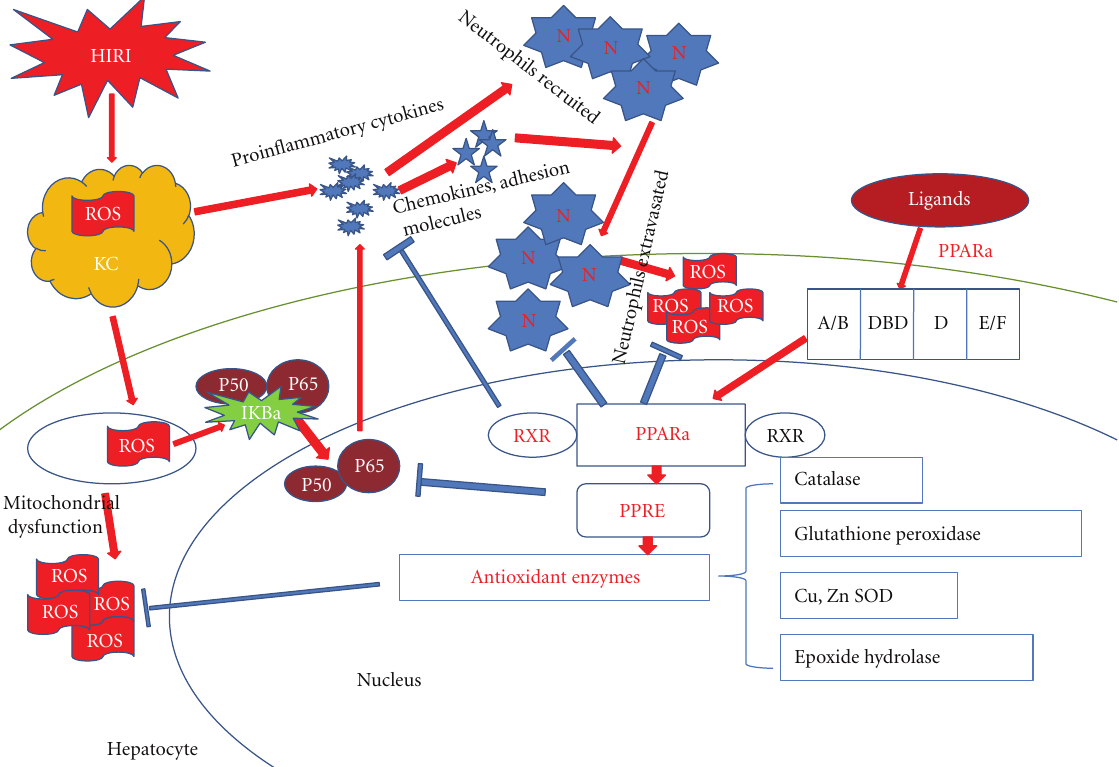
Figure 1: Protection mechanism of PPAR α in the liver during IR injury. Ischemic stress results in the generation of reactive oxygen species (ROS) in Kup ff er cells. ROS activates NF- κ B and induces mitochondrial dysfunction in neighboring hepatocytes. Activation of NF- κ B consequences in the production of proinflammatory cytokines, chemokines and adhesion molecules which can recruit neutrophils and propagate the inflammatory response. This vicious circle is breaked by PPAR α which is a ligand-activated transcription factor that upon heterodimerization with the retinoic X receptor (RXR), recognizes PPAR response elements (PPRE), located in the promoter of target genes. Abbreviations: Neutrophil (N), Kup ff er cell